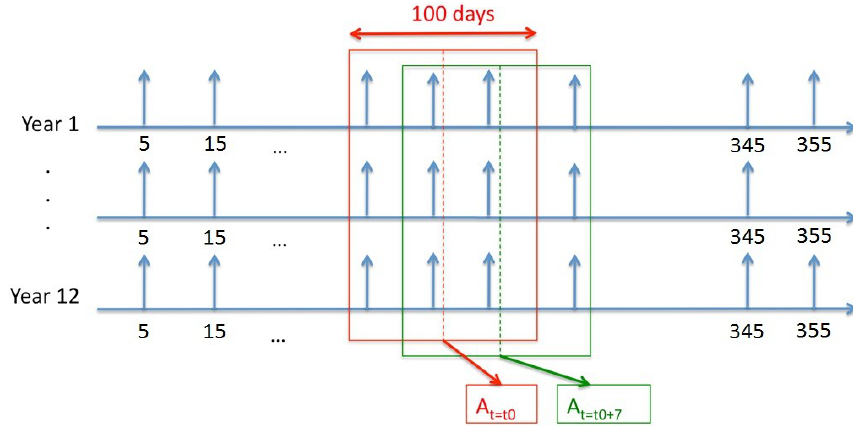
Fig. 4. Schematic of the strategy used to compose the “running” seasonal ensemble at assimilation time t .